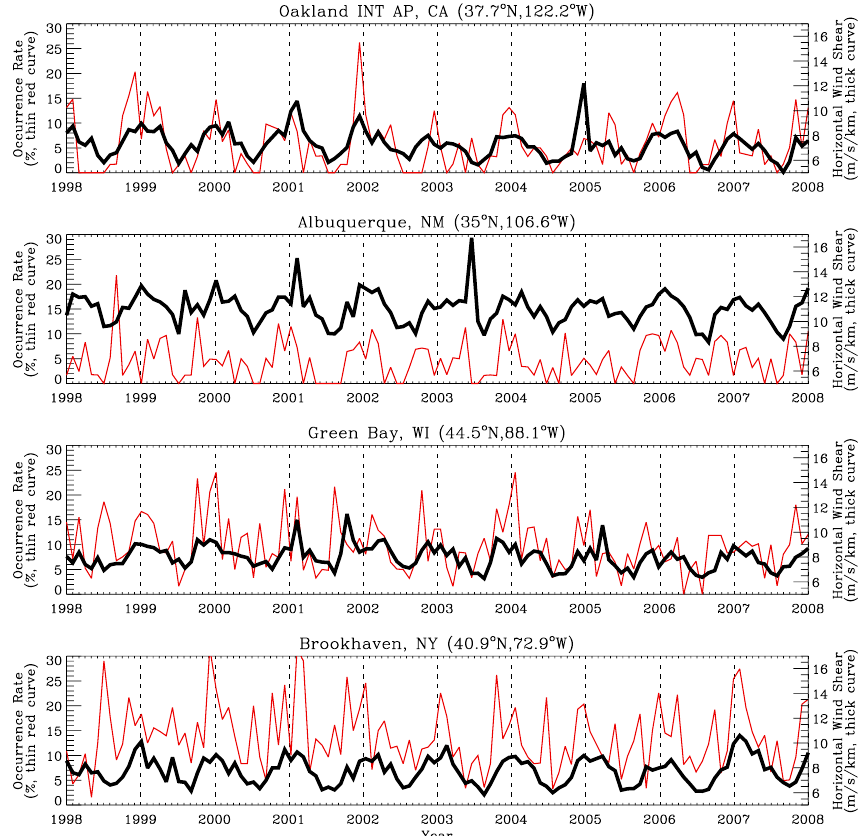
Fig. 4. Time series of the monthly occurrence rate of the lower tropospheric inversion (thin red curve) and mean horizontal wind shear in the range of 2–5km (thick curve) over 4 stations in